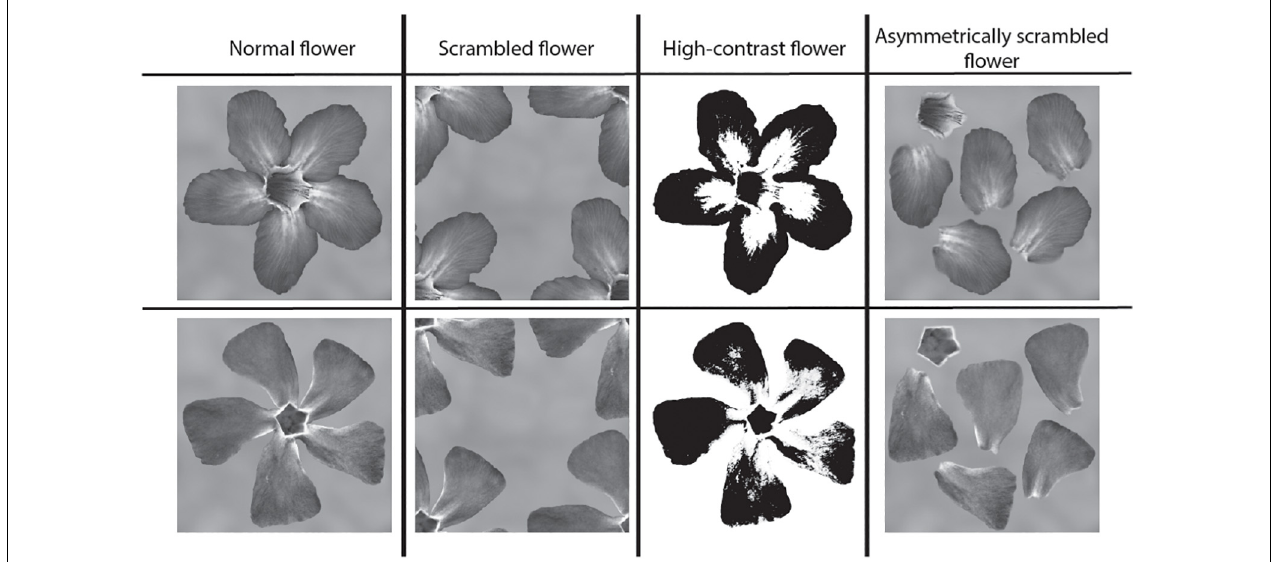
FIGURE 1 | The pairs of stimuli presented to bees learning to differentiate between two normal flower stimuli, two scrambled flower stimuli, two high contrast flower stimuli, and two asymmetrically scrambled flower stimuli. All stimuli contained the same image information compared to the normal flower images but differed in either contrast (black and white images compared to greyscale) or configuration of flower information (e.g., scrambled petals in image).